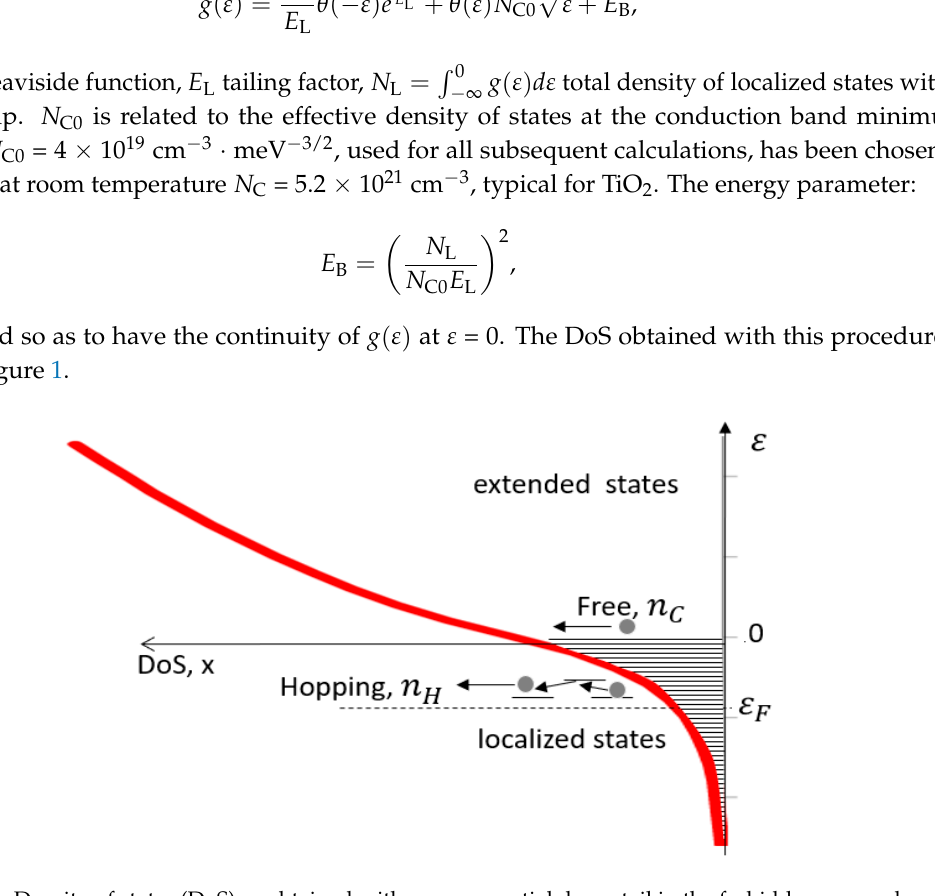
Figure 1. Density of states (DoS) as obtained with an exponential decay tail in the forbidden gap and a square root dependence in the conduction band region. The boundary is kept at ε C = 0, minimum of the conduction band. Conduction is due to both free electrons in the conduction band and to hopping at localized states.